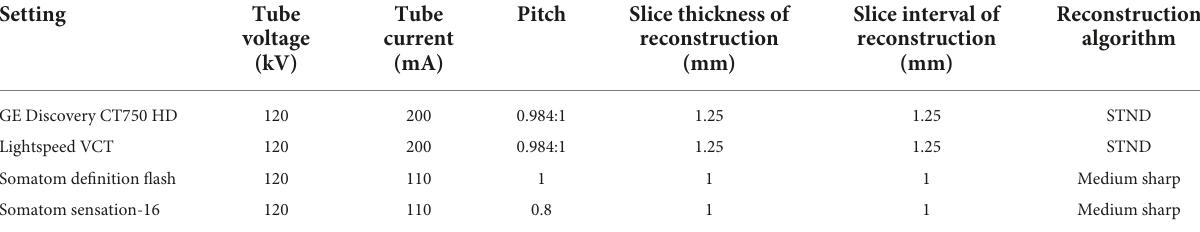
TABLE 1 Detailed scan and reconstruction